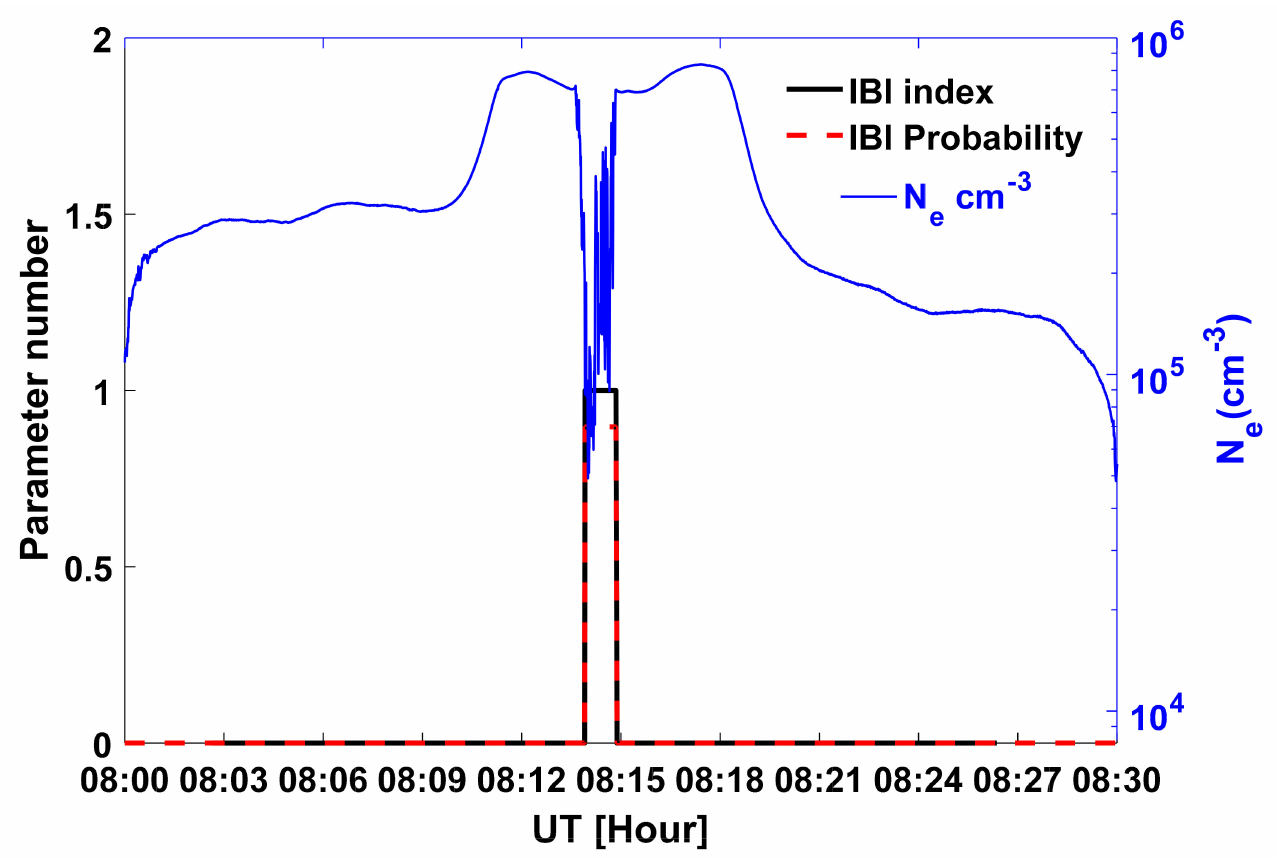
Figure 1. A typical example of an EPB/IBI event observed by Swarm B on March 17, 2015. Black solid line, red dashed line, and blue solid line correspond to the IBI index, the IBI probability, and the n e (cm − 3 ) profile,